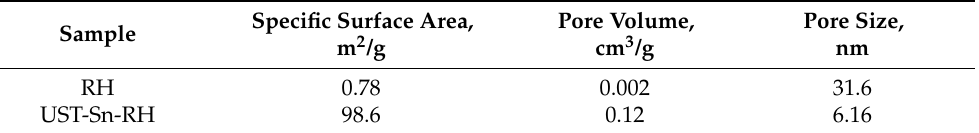
Table 1. Surface and pore properties of LS and UST-Sn-RH via Brunauer–Emmett–Teller (BET)